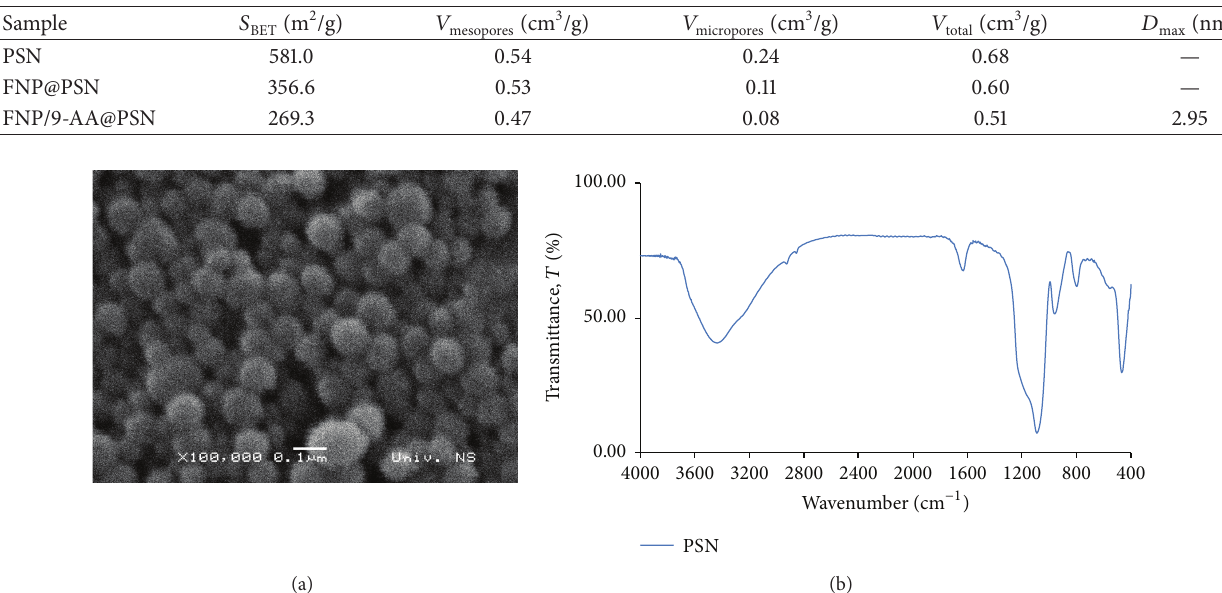
Table 1: Data obtained by nitrogen sorption measurements.